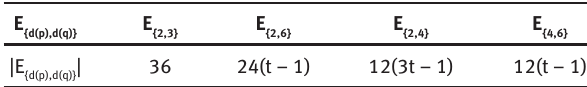
Table 5: The partition of the edges of MOF degrees of end